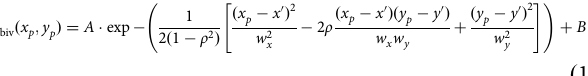
(Fig. 1, Supplementary Fig. 1) and fi t bivariate Gaussian models to the